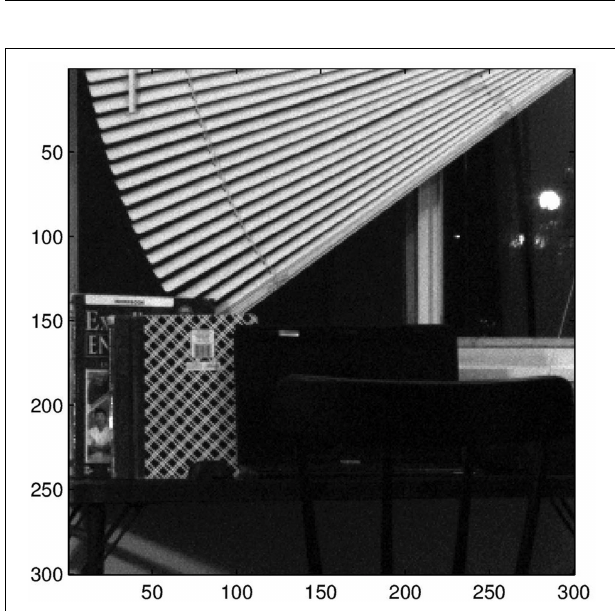
FIGURE 17 | The first real LR frame (data set II) which has been captured by an 8 bit gray-scale Imaging Source camera (DMK 23U618).